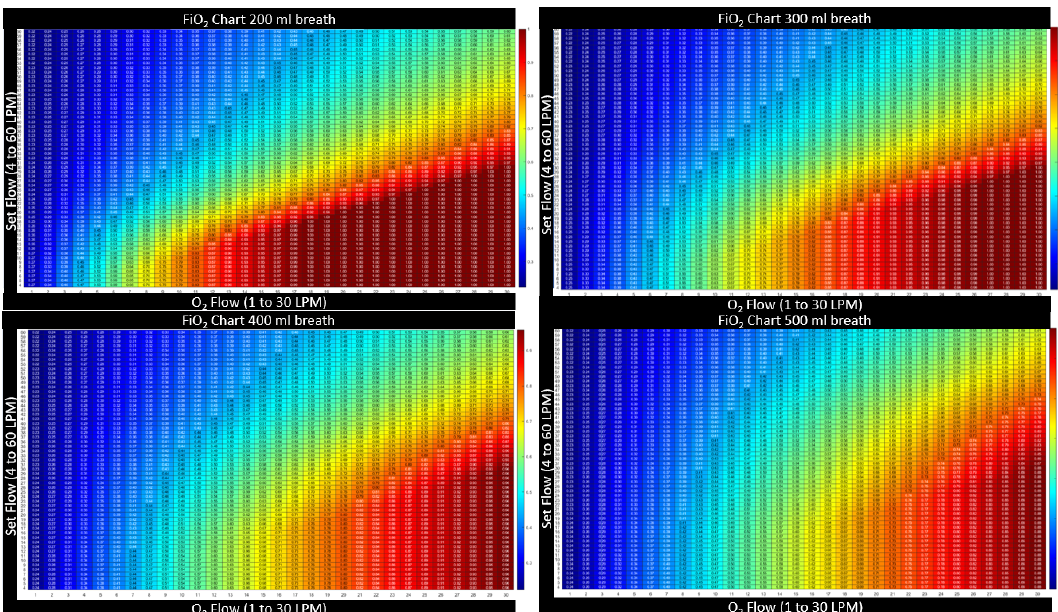
Figure 13. An illustration of all four F i O 2 charts for the four candidate breaths shows how both total flow settings and O 2 flow rate must increase with breath size. The deeper breaths with higher PIF require higher settings to achieve the desired tracheal F i O 2 . Here also note, indicated by the color trends on the charts, that increasing the flow setting always dilutes the tracheal F i O 2 .